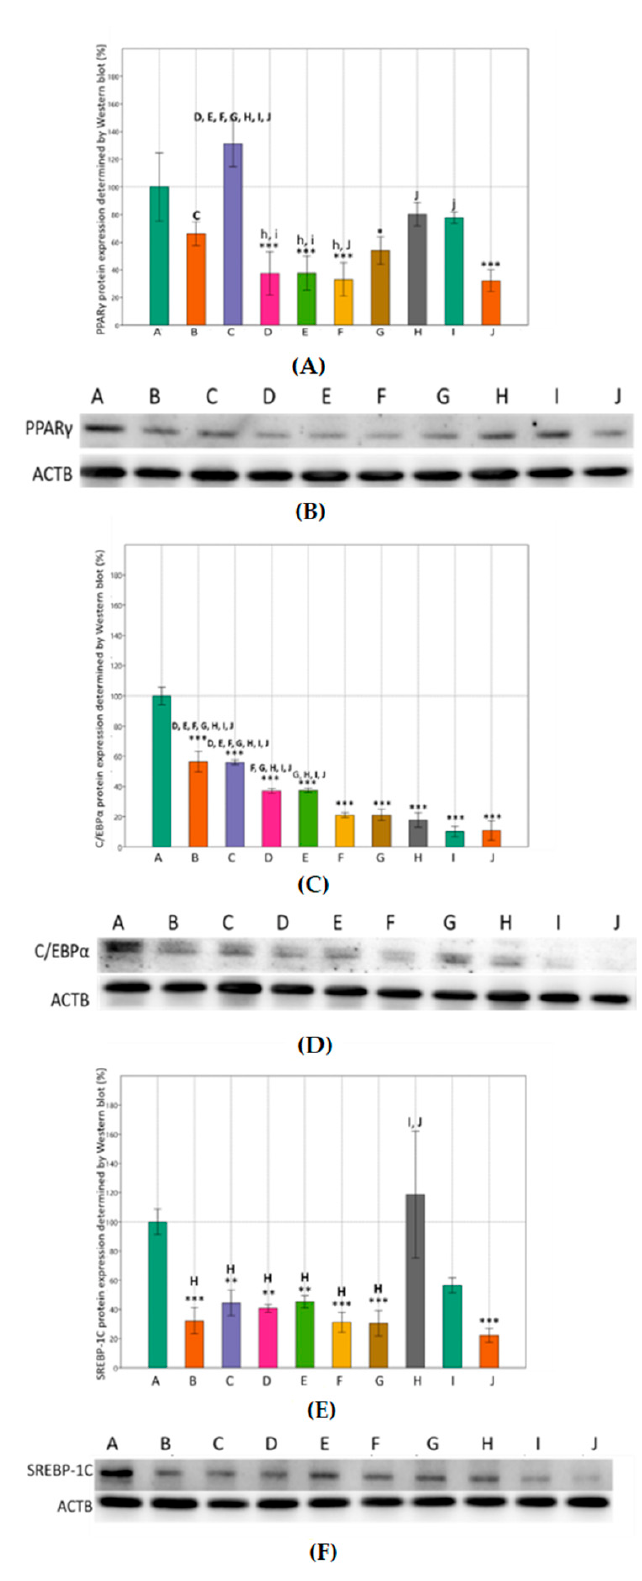
Figure 4. Effects of metformin and simvastatin on adipogenic protein expression in 3T3-L1 cells, determined by Western blot. A = differentiated cells, B = cells treated with metformin 200 µM, C = cells treated with metformin 2 mM, D = cells treated with metformin 4 mM, E = cells treated with